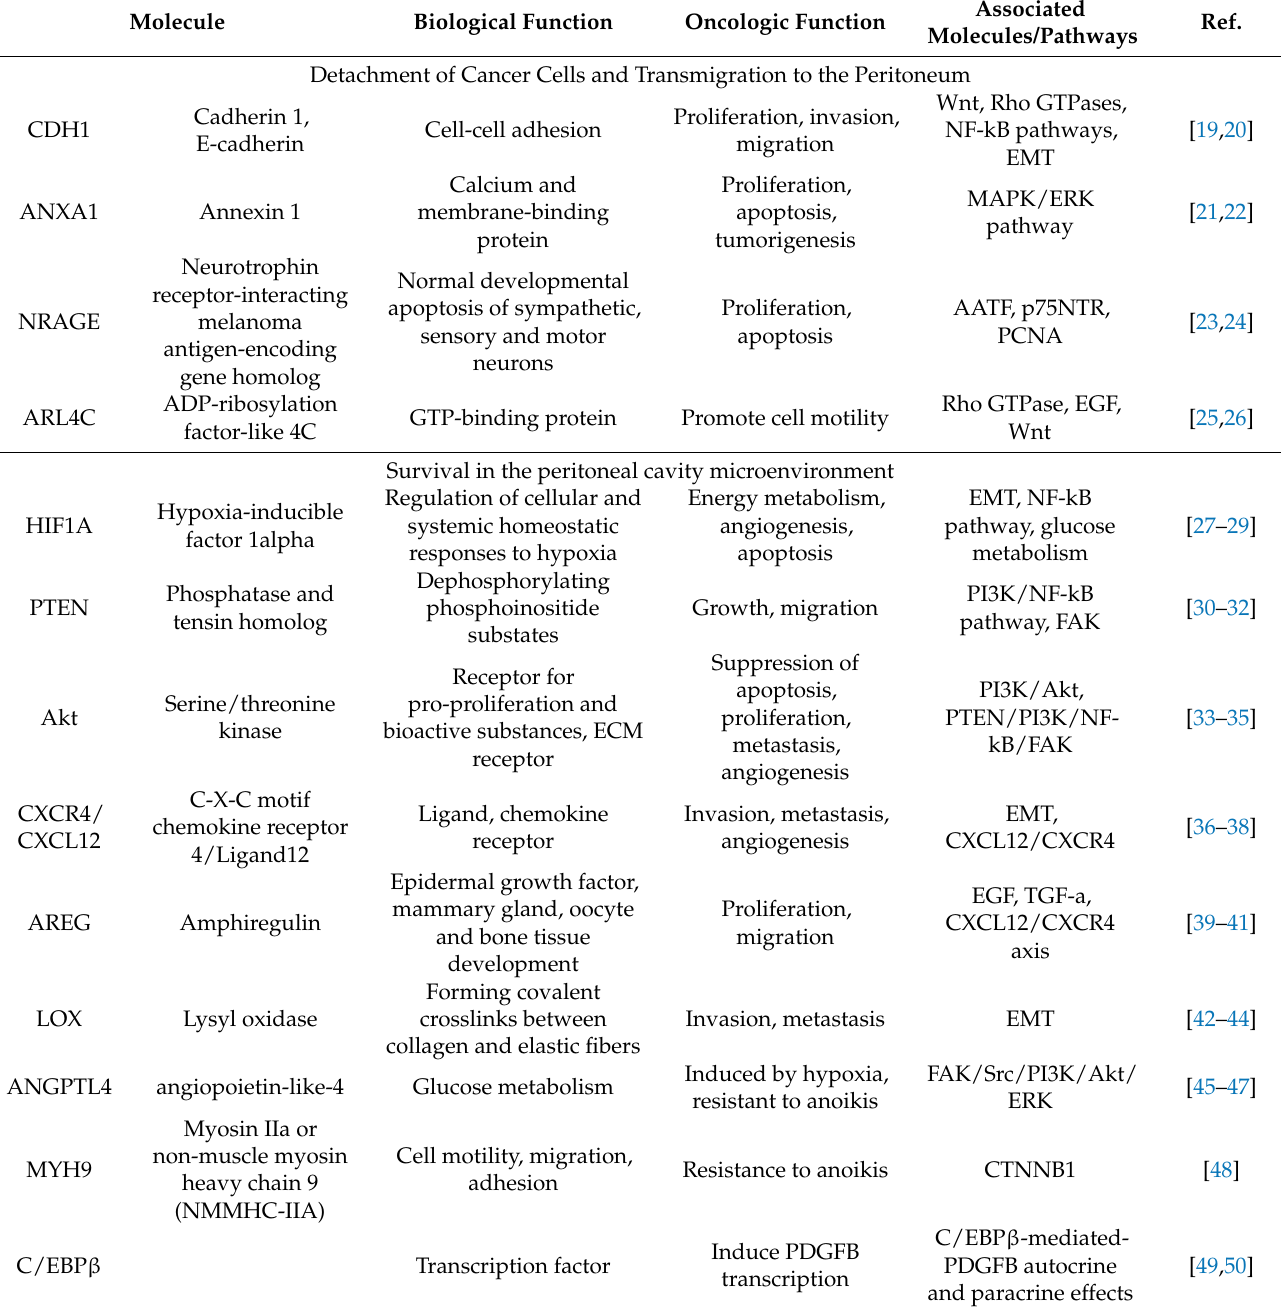
Table 1. Molecules associated with PM in